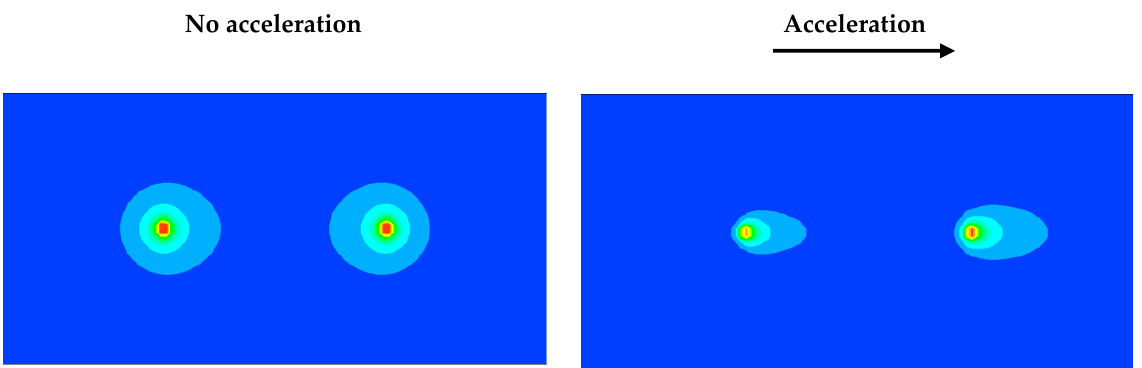
Figure 1. ( a ) Heater and temperature sensors; ( b ) temperature profile with and without acceleration (adapted from [1]).